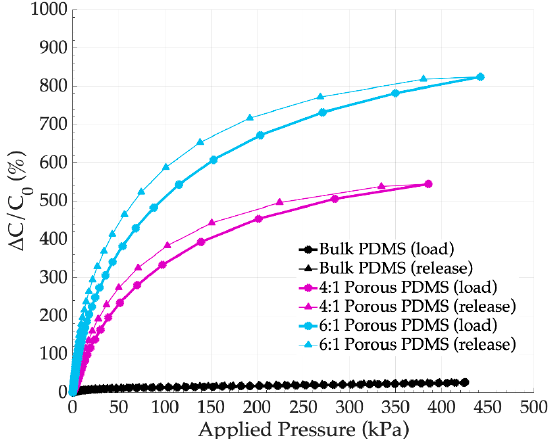
Figure 6. Variation of the capacitance according to the applied pressure, depending on the sugar:PDMS ratio (small pores PDMS foam, ( d 0 = 5 mm ± 0.5 mm). Table 2. Summary of the characterization results for PDMS bulk film and porous PDMS film as